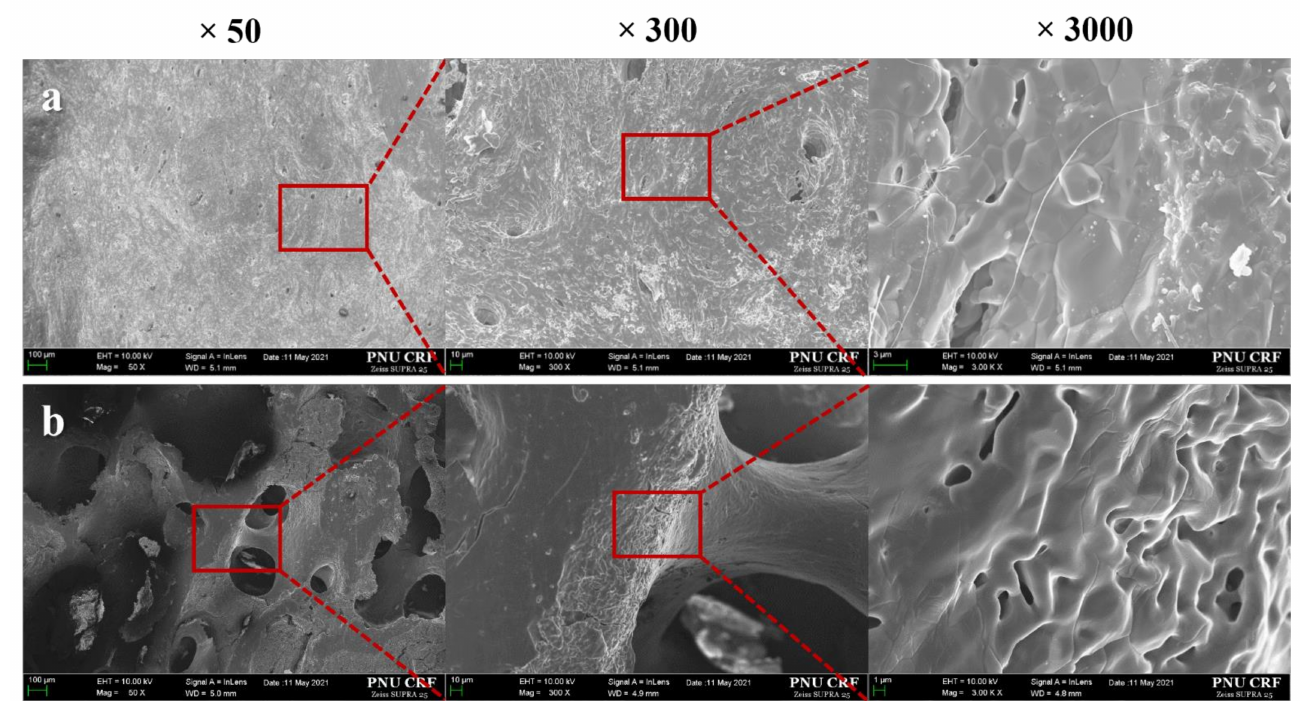
Figure 1. Scanning electron microscopy images of the surface. ( a ) Cortical group, ( b ) Cancellous group.